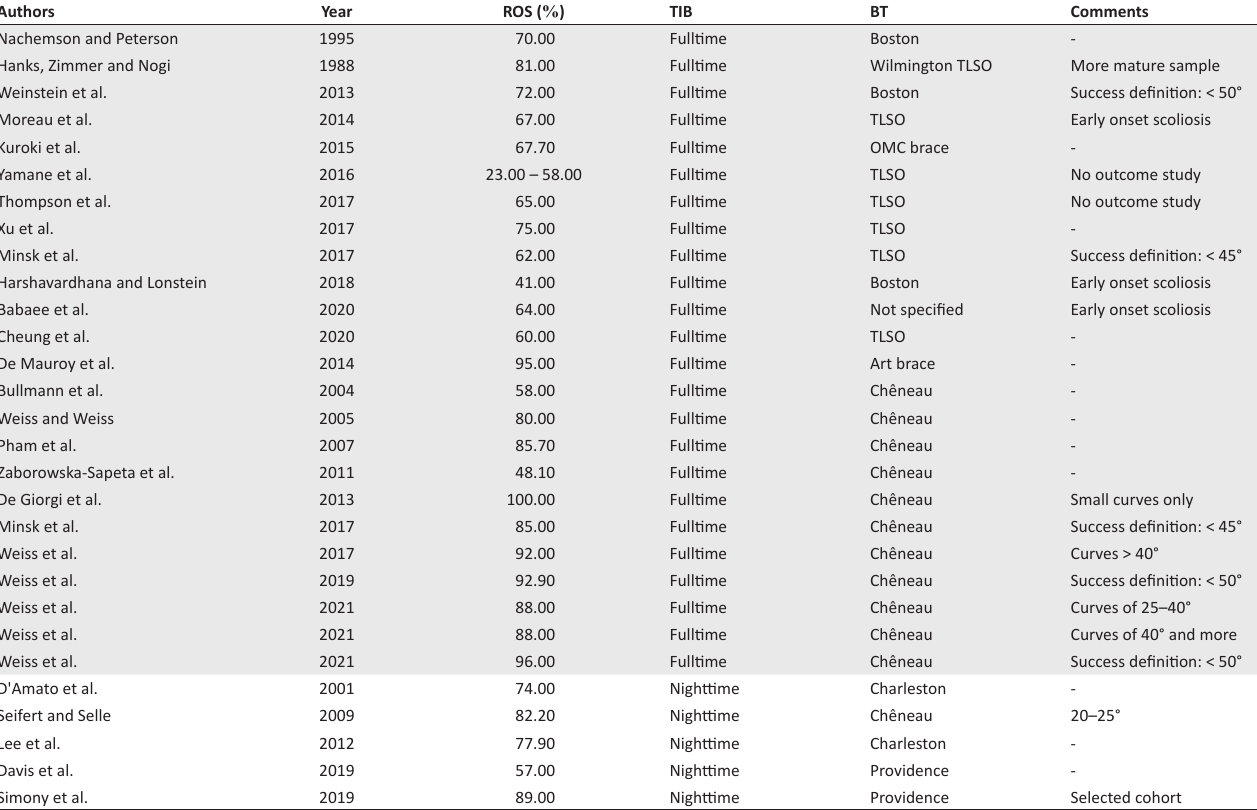
TABLE 1: Rate of success variations as found in literature for brace treatment for patients with idiopathic scoliosis. Authors